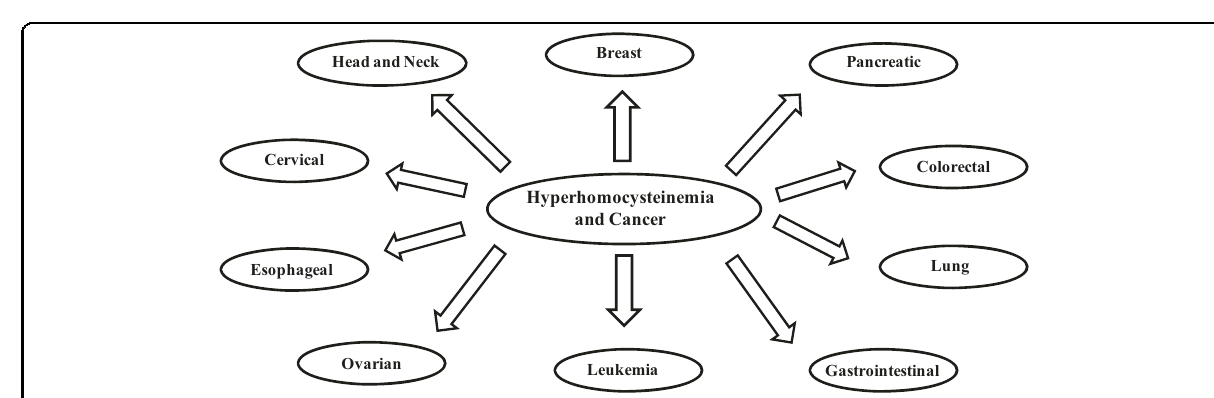
Fig. 1 Association between hyperhomocysteinemia and various cancer